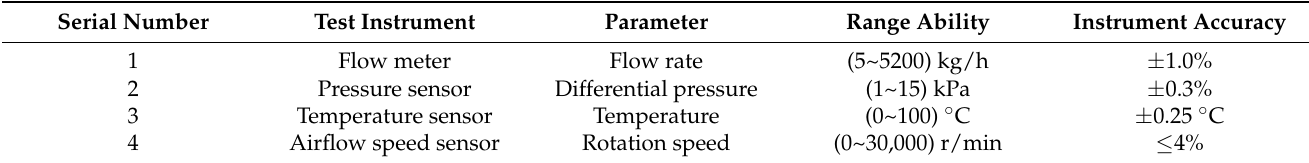
Table 4. Accuracy requirements of test equipment.